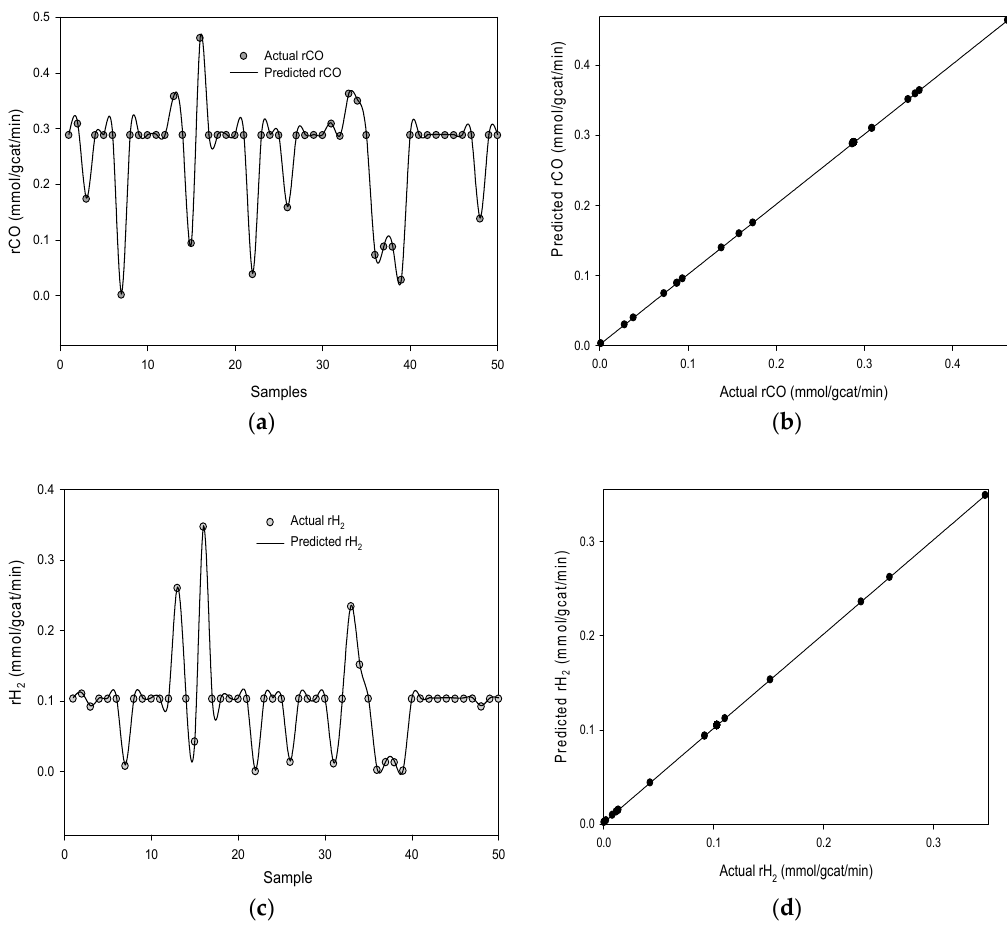
Figure 6. ( a ) Dispersion plot showing the comparison between actual and predicted rCO; ( b ) Parity plots showing the comparison between actual and predicted rCO; ( c ) Dispersion plot showing the comparison between actual and predicted rH 2 ; ( d ) Parity plots the comparison between actual and predicted rH 2 using Leven–Marquardt